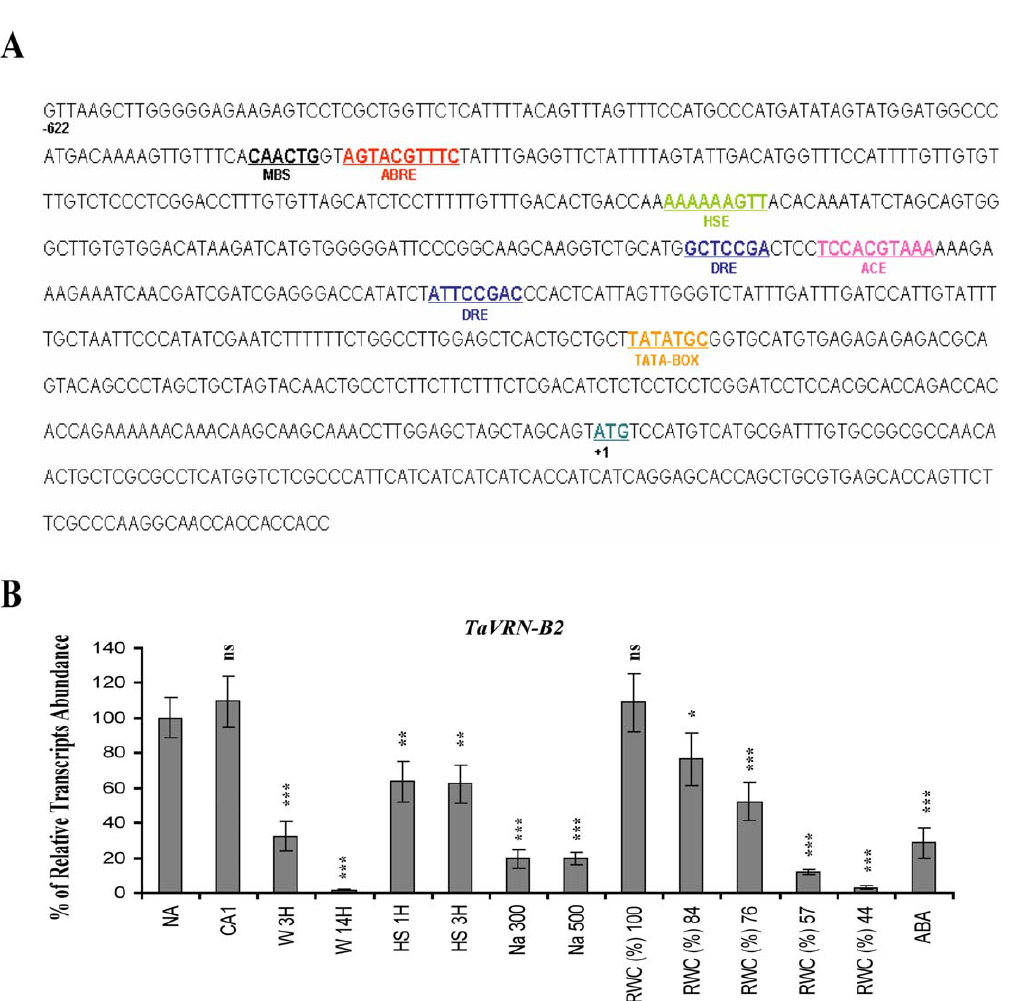
Figure 3. Promoter analysis and transcripts level of TaVRN2 in response to various abiotic stresses. A) Putative regulatory cis -elements in TaVRN2 promoter ( MBS: MYB binding site involved in drought-inductibilty, ABRE: cis -acting element involved in abscisic acid responsiveness, HSE: cis -acting element involved in heat stress responsiveness, ACE: cis-acting element involved in light responsiveness, DRE: cis-acting element involved in cold stress and TATA-box). The plant CARE and PLACE programs were used for the promoter analysis. B) Transcripts abundance in winter wheat exposed to various stresses. Seven days old plants were exposed to different stresses: Non-acclimated (NA), cold acclimated (CA), wounding (W), heat shock (HS), salt (NaCl), water stress (RWC), abscisic acid (ABA). Data shown represent mean values obtained from independent amplification reactions (n=4), experiment was repeated three times with similar results. A statistical difference between each sample and the expression observed in non acclimated plants is indicated by an asterisk on top of each histogram columns. The threshold for statistical significance was: *: p , 0.05; **: p , 0.01; ***: p , 0.001; ns: P . 0.05.